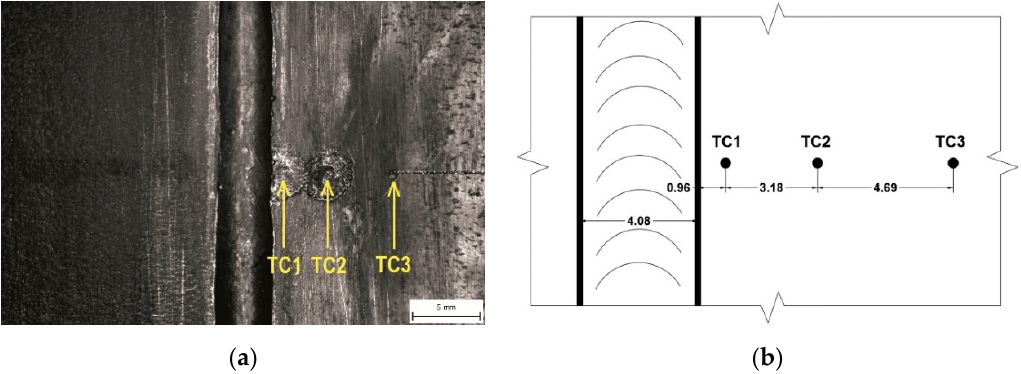
Figure 2. Position of thermocouples on the root side of the weld: ( a ) marking the locations of the welded thermocouples; ( b ) geometry of the thermocouple position from the edge of the weld root.